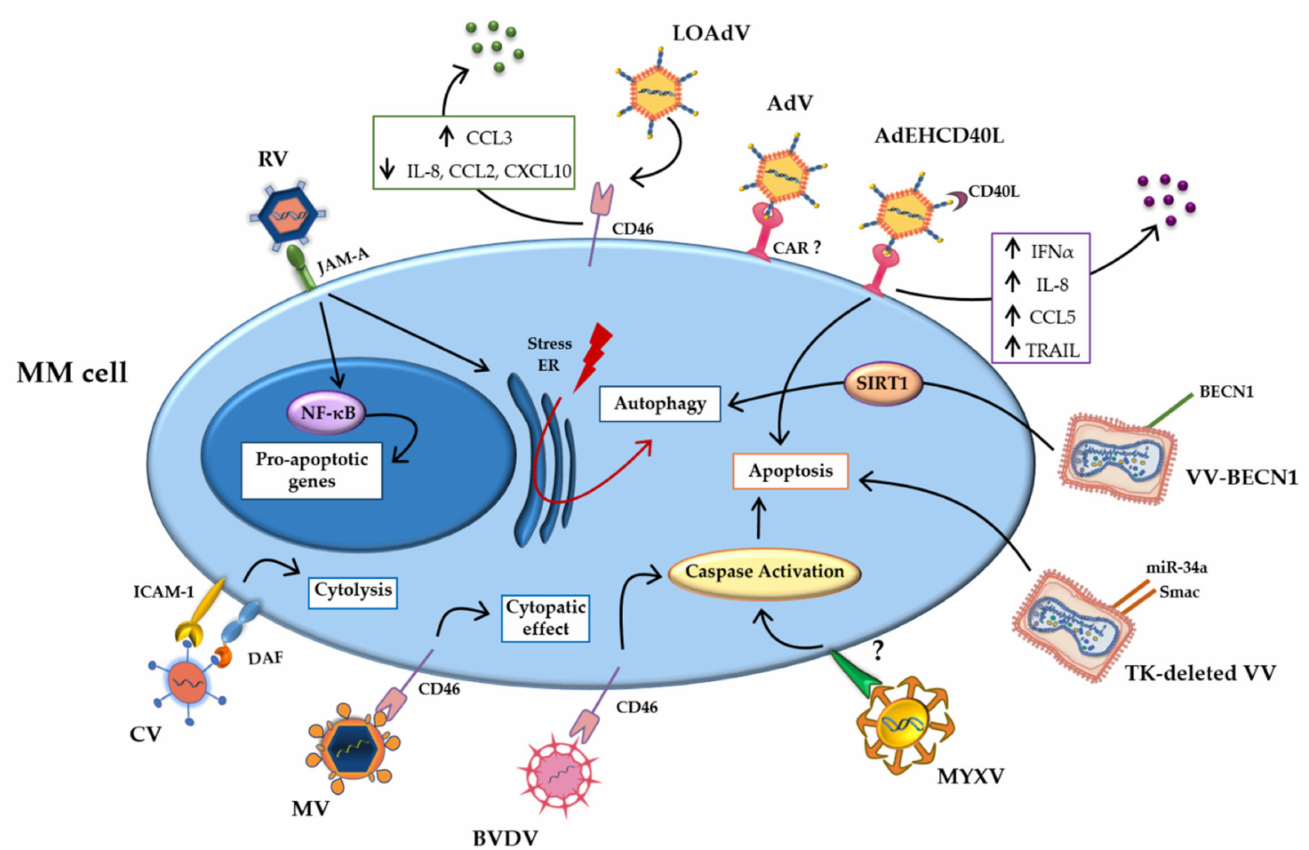
Figure 1. Direct mechanisms of oncolytic viruses. Schematic representation of direct mechanisms of the oncolytic viruses studied in multiple myeloma (MM) cells, showing the main pathways activated by oncolytic infection. Abbreviations: AdV: Adenovirus; BECN-1: Beclin-1; BVDV: Bovine viral diarrhea virus; CAR: coxsackievirus and adenovirus receptor; CCL2: Chemokine (C-C motif) ligand 2; CCL3: Chemokine (C-C motif) ligand 3; CCL5 Chemokine (C-C motif) ligand 5; CD40L: CD40-ligand; CXCL10: C-X-C motif chemokine ligand 10; CV: Coxsakie virus; DAF: decay-accelerating factor; ER: Endoplasmic reticulum; ICAM-1: intercellular adhesion molecule; INF α : Interferon α ; IL-8: Interleukin-8; JAM-A: Junctional adhesion molecule-A; LOAd: Lokon oncolytic Adenovirus; MM: Multiple myeloma; MYXV: Myxoma Virus; MV: Measles virus; NF- κ B: Nuclear factor kappa-light-chain-enhancer of activated B cells; NIS: Sodium iodide symporter; RV: Reovirus; SIRT1: Sirtuin1; TK: thymidine kinase; TRAIL: TNF-related apoptosis-inducing ligand; VV: Vaccinia